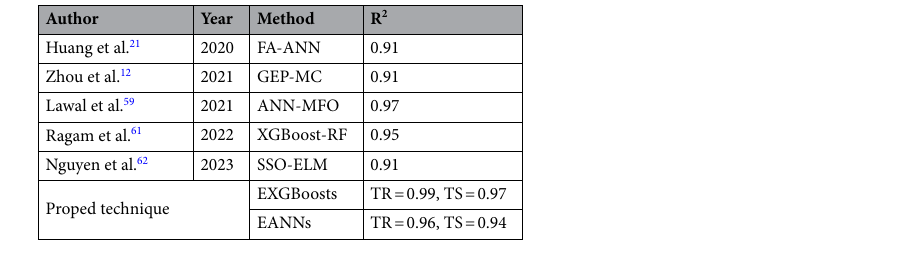
Table 9. Accuracy comparison of our proposed technique with other reseach. TR Train, TS Test.